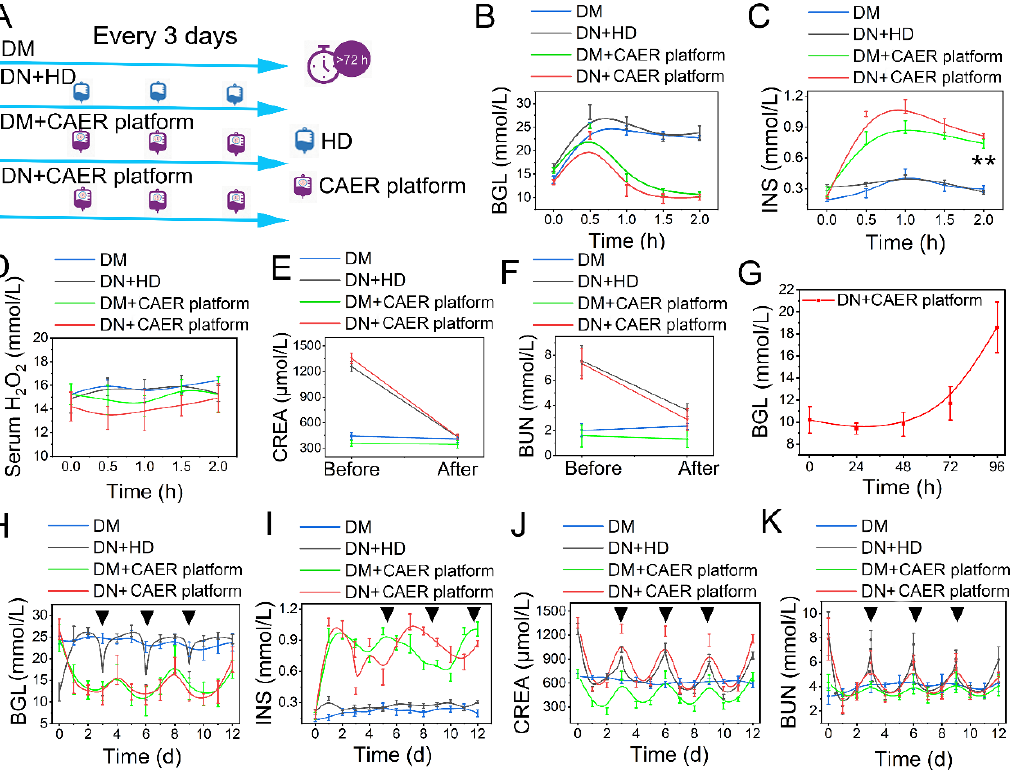
Figure 5. Evaluation of glycemic control and dialysis effect of the CAER platform. ( A ) Schematic of experimental design. The rabbits were randomly allocated into four groups and received different treatments: (1) DM: diabetic rabbits, set as control. (2) DN + HD: DN rabbits received hemodialysis (HD) treatment every 3 days. (3) DM + CAER platform: diabetic rabbits received the CAER platform treatment every 3 days. (4) DN + CAER platform: DN rabbits received the CAER platform treatment every 3 days. ( B – F ) The oral glucose tolerance test results in vivo. ( B ) The BGL curve. ( C ) The change curve of serum INS concentration. ( D ) The curve of serum H 2 O 2 concentration. ( E ) Change in serum CREA concentration. ( F ) Concentration changes of BUN in serum. ( G ) The curve of blood glucose level after one treatment. ( H – J ) The results of long treatment (once every three days). The black tringles indicated the treatment time. ( H ) The curve of blood glucose level after multiple treatments. ( I ) The change curve of blood INS concentration after multiple treatments. ( J ) CREA concentration changes. ( K ) Concentration changes of BUN in serum after multiple treatments. ** p <